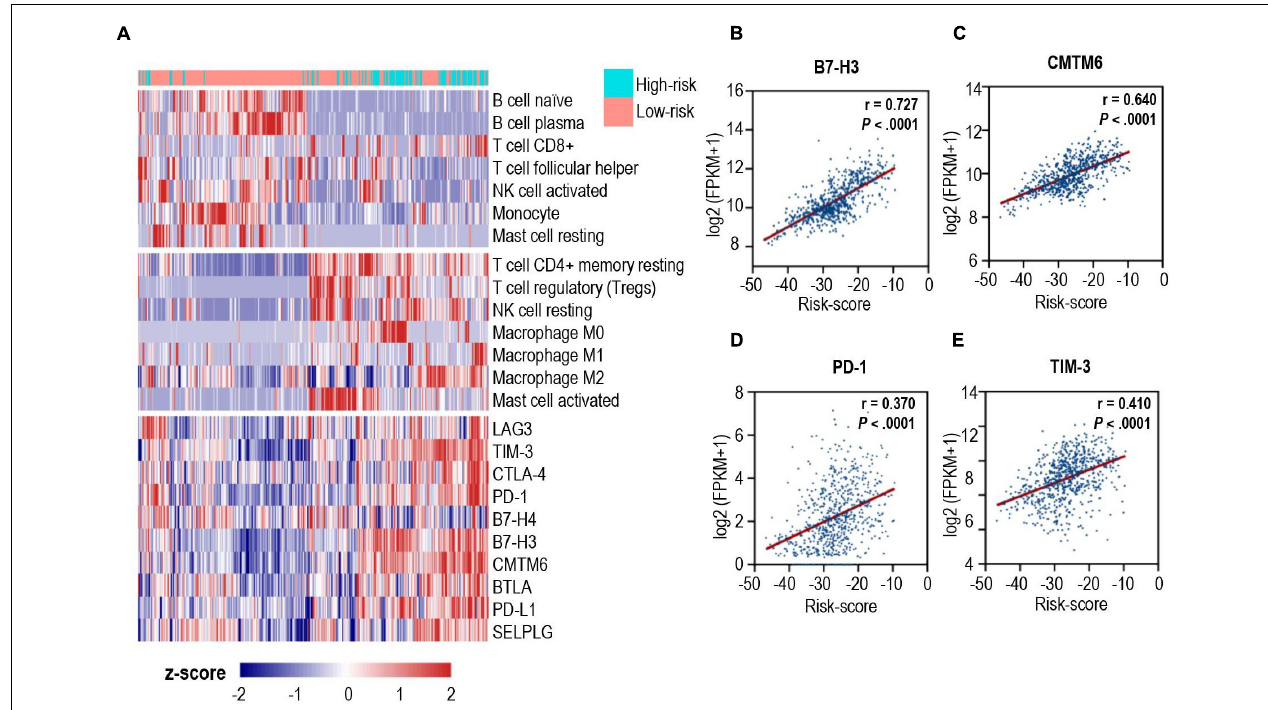
FIGURE 4 | Correlation analysis between calcium-related risk score and pivotal immune checkpoints. (A) Heatmap showed the unsupervised cluster analysis of each immune cell proportion and immune checkpoints and calcium-related risk score in TCGA glioma cohort ( n = 691 patients). (B–E) The correlation between calcium-related risk score and the expression of B7-H3 (B) , CMTM6 (C) , PD-1 (D) and TIM-3 (E) . Pearson correlation coefficient, also known as Pearson R statistical test, was shown at the top right corner of each